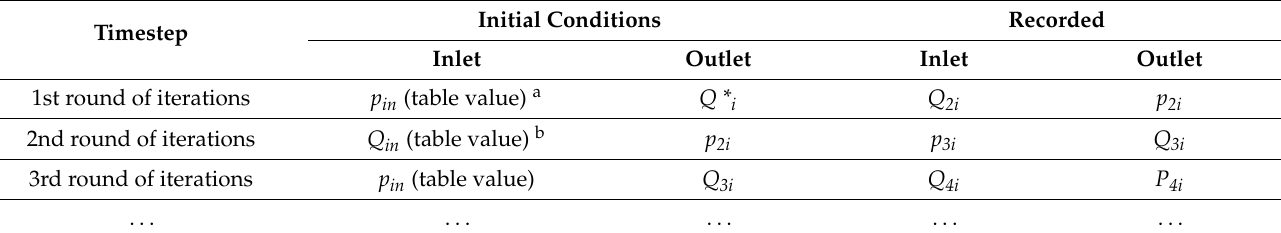
Table 1. Workflow procedure of rapid iterative algorithm.